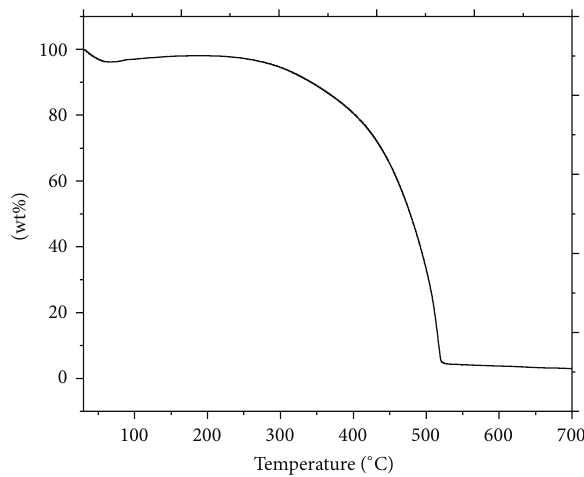
Figure 5: TGA of PyP obtained at up to 700 ∘ C using a linear 3 ∘ C/min ramp